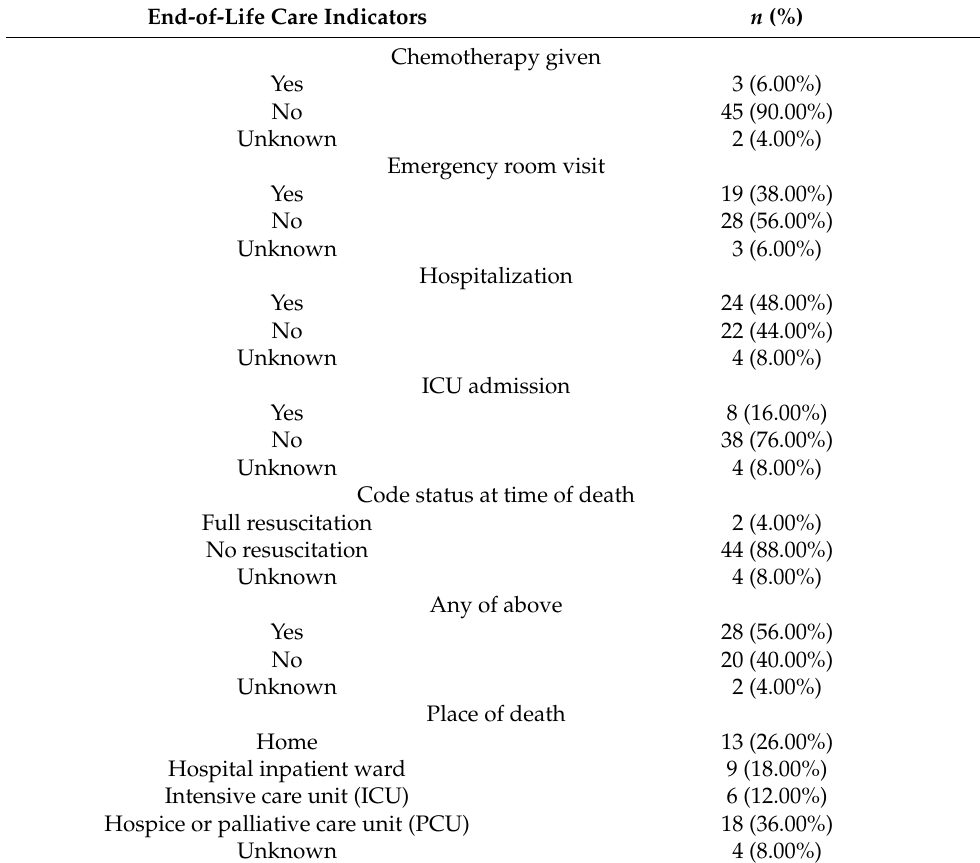
Table 4. End-of-life care indicators in